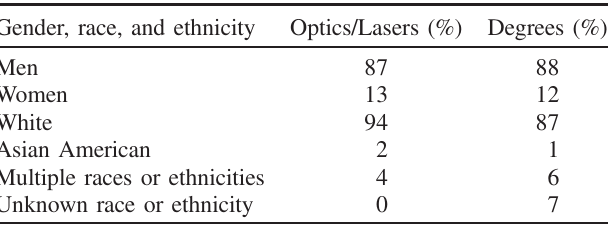
TABLE I. Demographic breakdowns of two populations at Bethel: students who completed Optics or Lasers Lab (about 20 per semester) and those who earned a physics or applied physics bachelor ’ s degree (about 20 per year) between 2010 and 2016. Data were provided by the Office of Institutional Data and